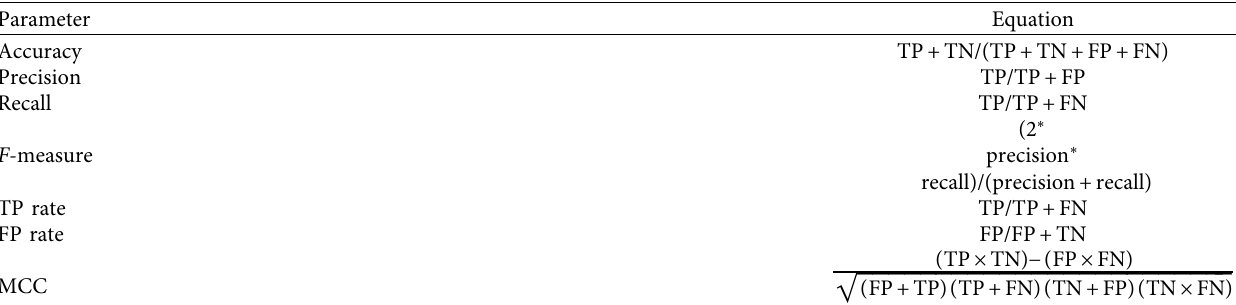
Figure 11: KNN classifier. Table 2: Evaluation parameters.